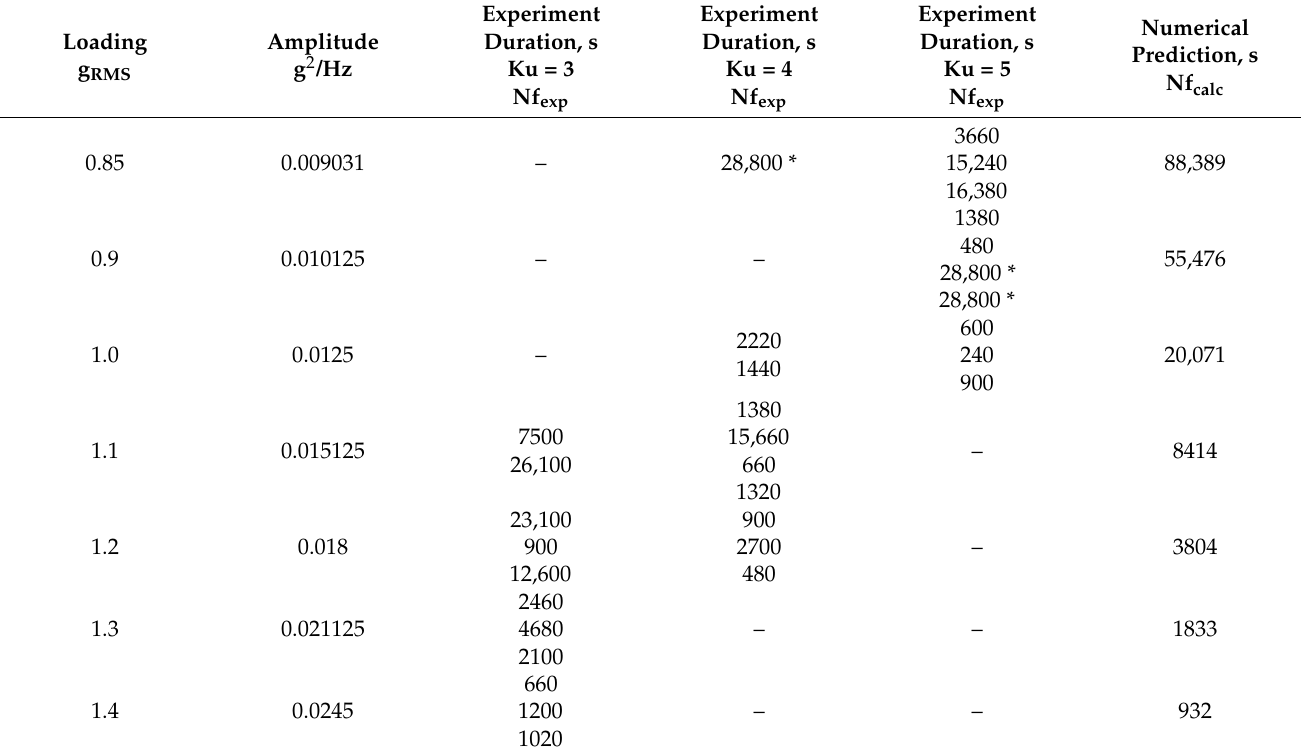
Table 5. Experimental results and numerical prediction for tested cases with different kurtosis values.